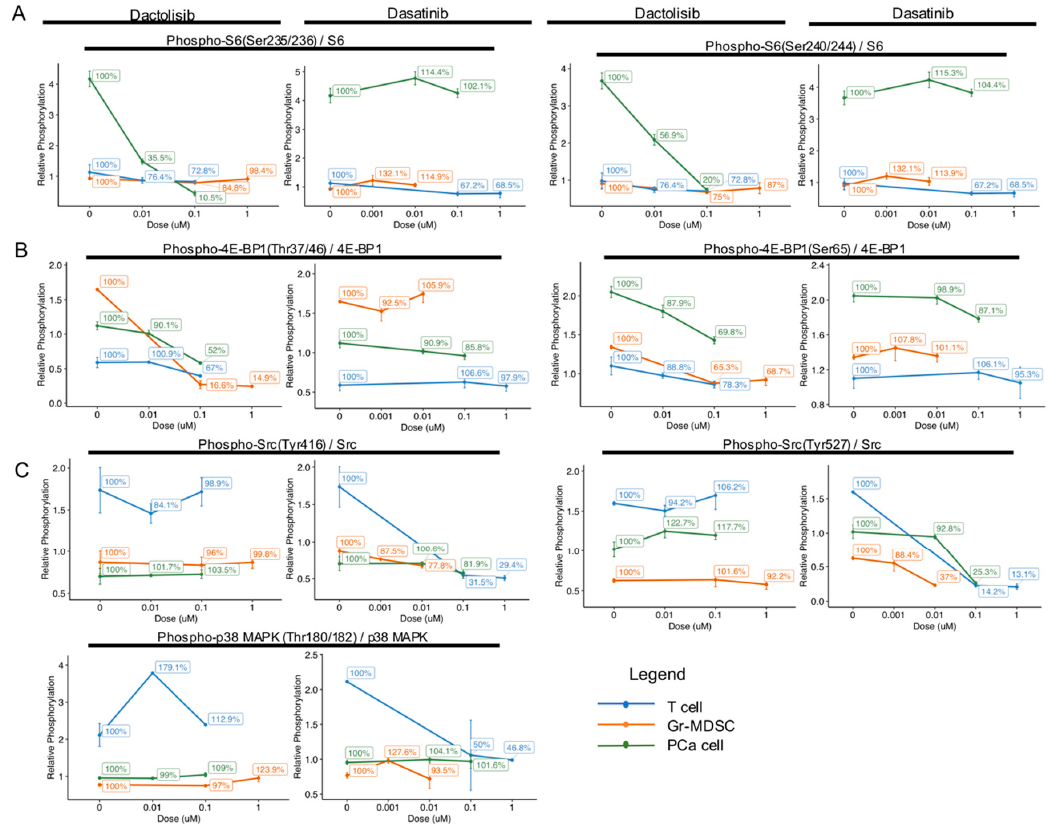
Figure 3. Cell type-specific downregulation of phosphorylation levels of S6, 4E-BP1, Src and p38 MAPK by Dactolisib and Dasatinib. Phosphorylation level of the specified proteins was normalized to total protein level, and relative percentage was calculated with no drug treatment (0 µ M) as 100%. ( A ) The phosphorylation of S6 at Ser235 / 236 and Ser240 / 244 dramatically decreased in PCa cells by Dactolisib, while Dasatinib had little e ff ect. ( B ) The phosphorylation of 4E-BP1 at Thr37 / 46 in Gr-MDSCs was dramatically decreased by Dactolisib. The phosphorylation of 4E-BP1 at Ser65 in Gr-MDSCs, T cells and PCa cells was mildly decreased by Dactolisib. Dasatinib had little e ff ect. ( C ) The phosphorylation of Src at Tyr416 and Tyr527 and p38 MAPK at Thr180 / 182 was dramatically decreased in T cells by Dasatinib, but not Dactolisib. In each plot, data represent mean ± standard error of the mean.